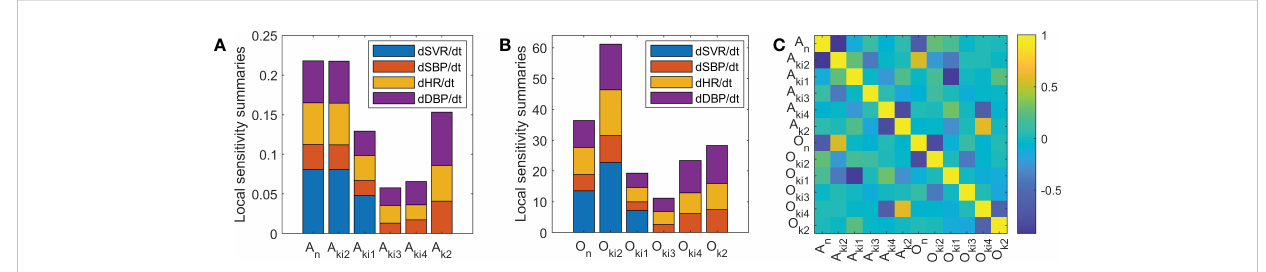
FIGURE 4 Sensitivity and identi fi ability analysis for Ta-dependent effect model of valsartan. (A) Local sensitivity summaries of A parameters. (B) Local sensitivity summaries of O parameters. (C) Correlation matrix between model parameters.